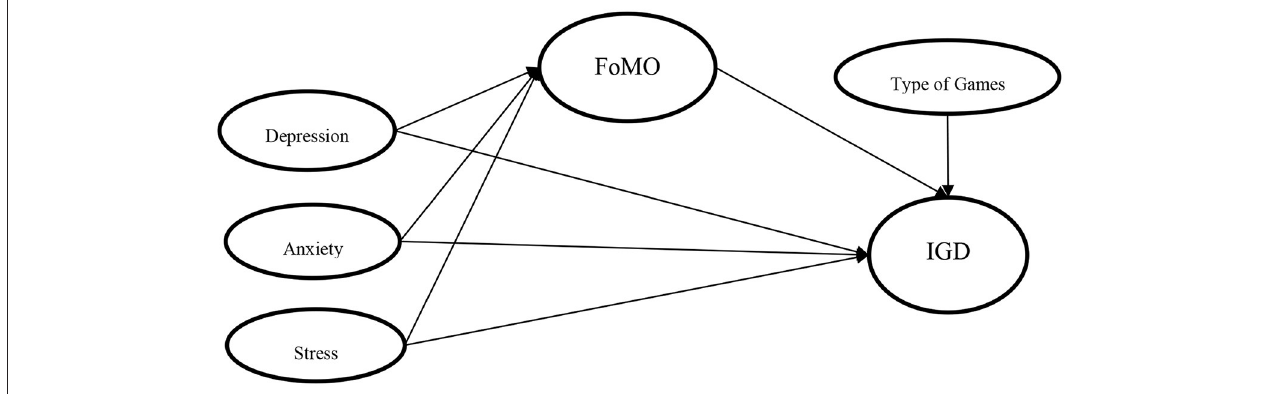
FIGURE 1 | Relation diagram of various variables. FoMO, fear of missing out; IGD, Internet Gaming